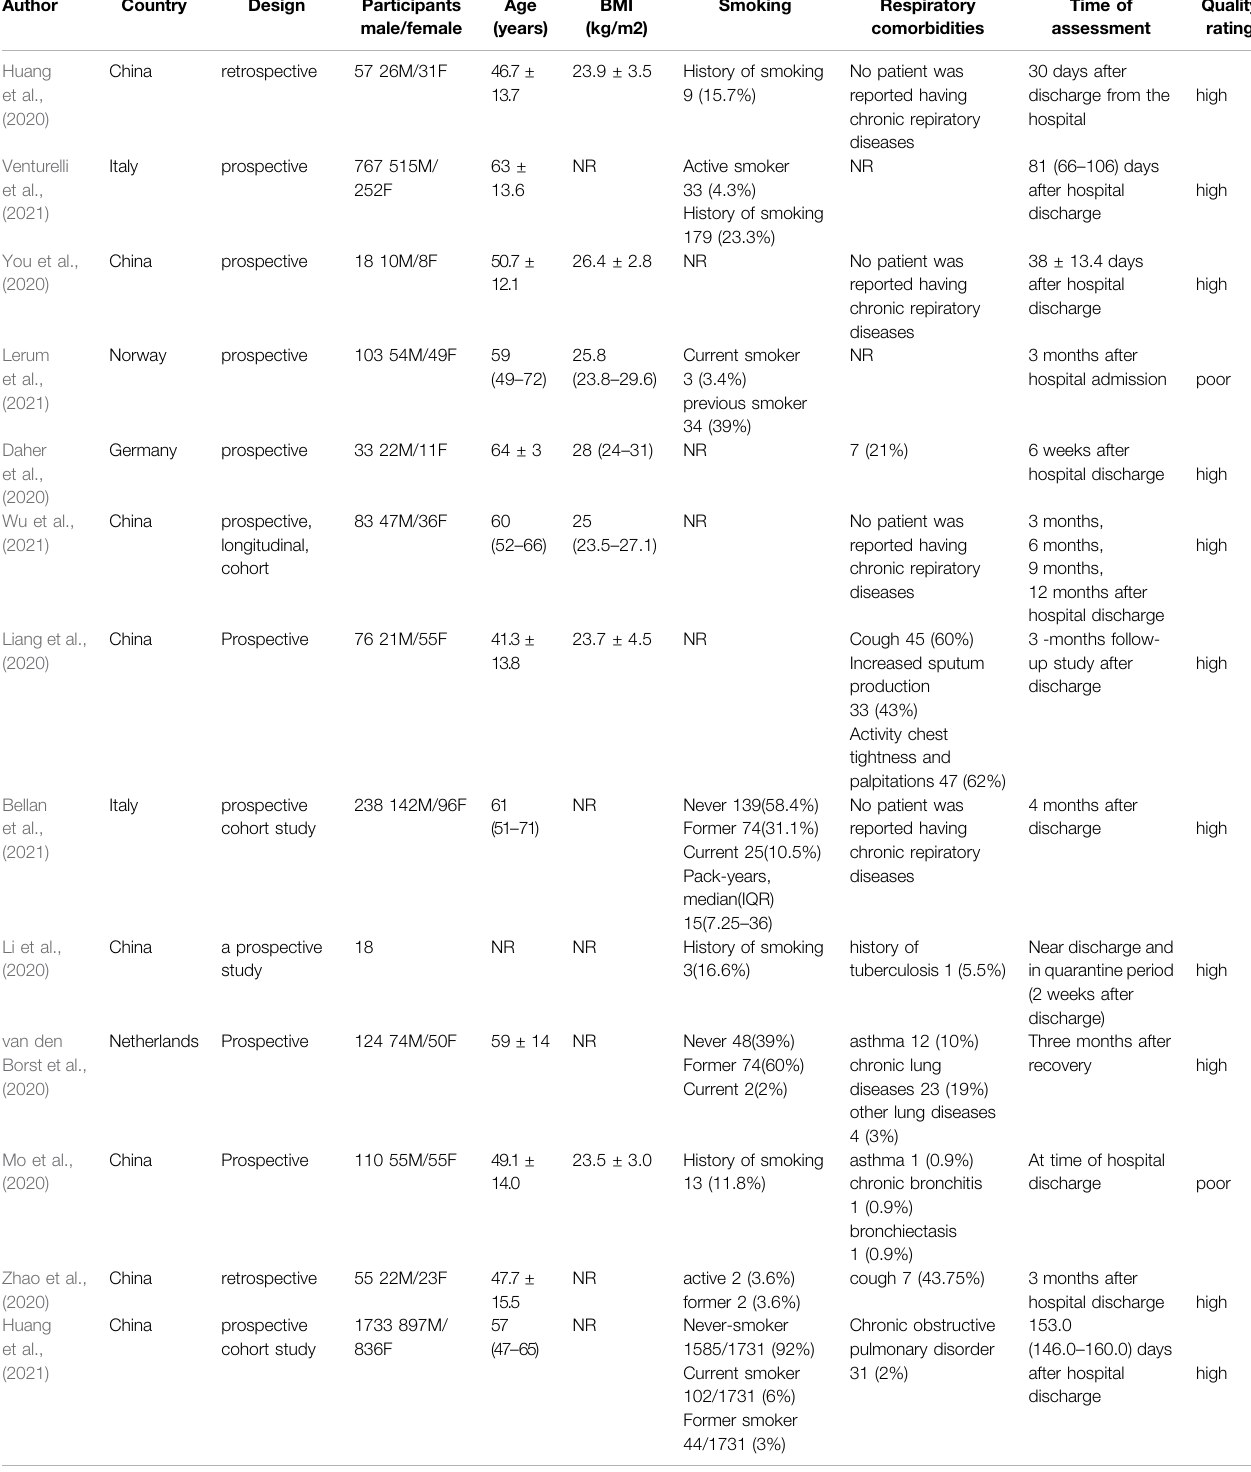
TABLE 1 | Basic characteristics of included